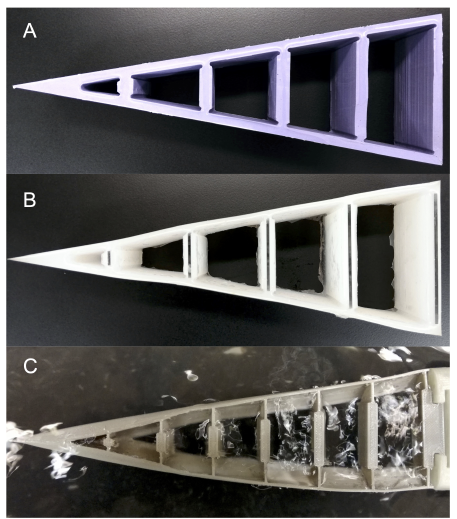
Figure 2. Stern models ( A – C ). Models ( A ) and ( B ) were cast from silicone rubber with different Young’s modulus to proof our hypothesis. Model C was 3D-printed from thermoplastic polyurethane (TPU, NinjaFlex R (cid:13) , NinjaTek R (cid:13) , Manheim, PA, USA) and represents the stern of a down-scaled canoe boat model.